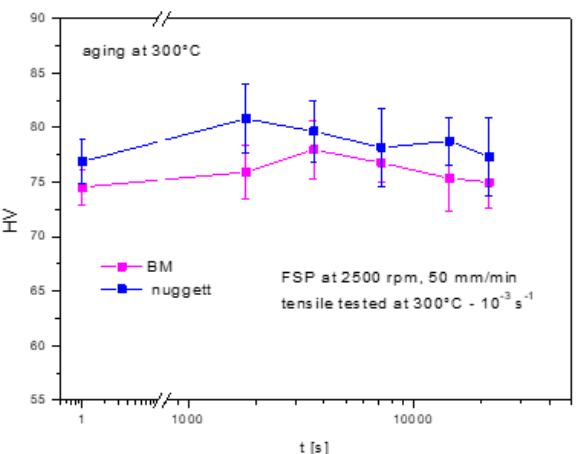
Figure 7. Microhardness measured in the nugget and in the BM regions of tensile samples tested at 300 °C, 10 − 3 s –1 and subsequently aged at 300 °C.